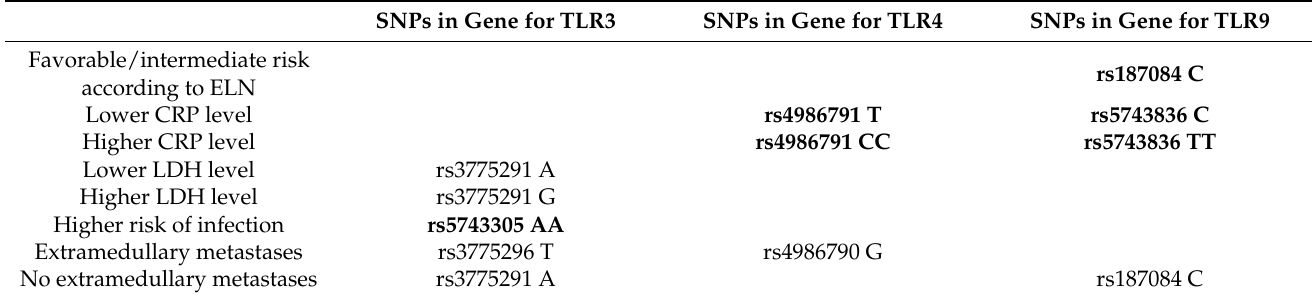
Table 1. Summary of correlations between SNPs in genes coding for TLR3, TLR4, and TLR9 and different clinical features in patients with AML. For statistically significant results ( p < 0.05), bold font is used.